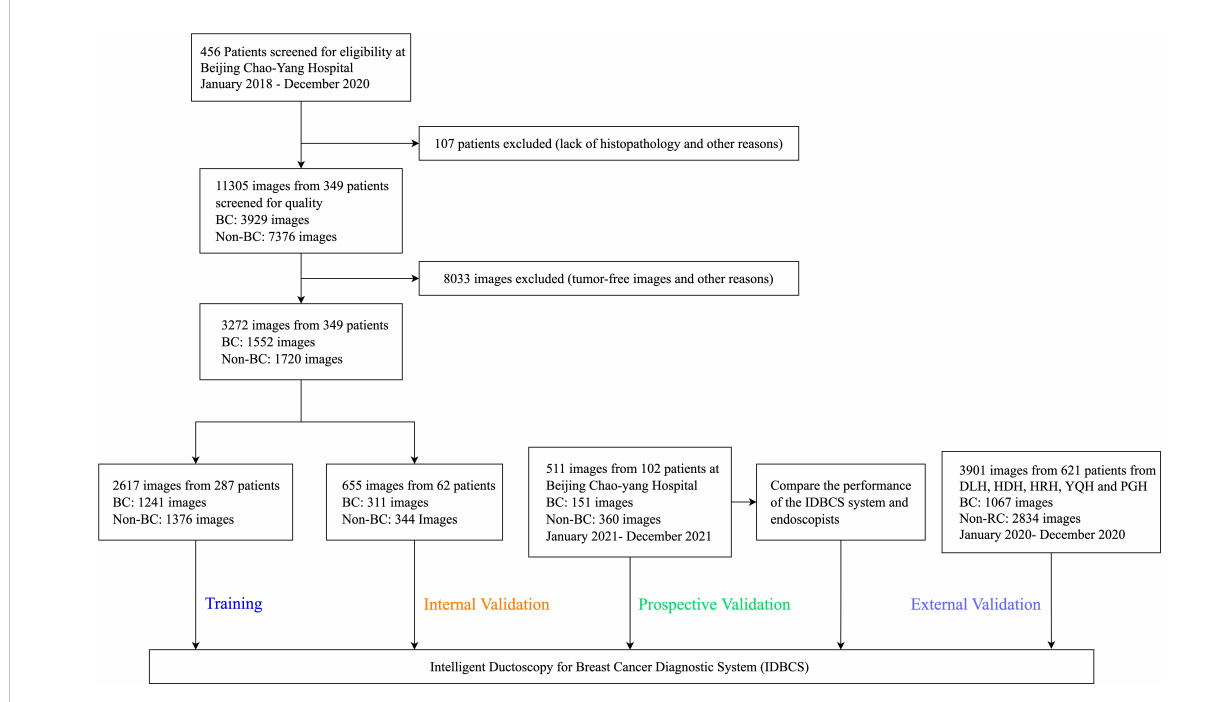
FIGURE 2 Flowchart for the development and validation of the IDBCS system for diagnosing breast cancer with pathological nipple